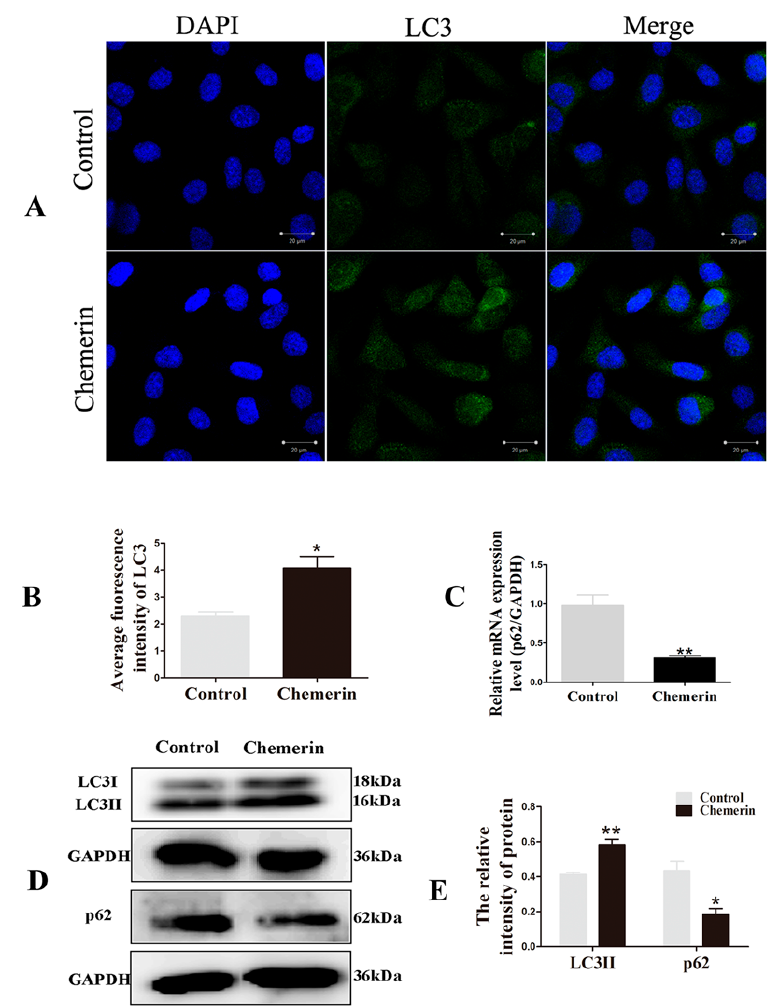
Figure 2. Chemerin promotes autophagy of BMECs. Cells were exposed to the culture medium with 0.1µg/mL Chemerin form 24 h. ( A ) LC3 protein distribution was detected by immunofluorescence staining. ( B ) The average fluorescence intensity of LC3 was determined in three randomly selected fields of view by Image J software. ( C ) Messenger RNA (mRNA) expression of sequestosome-1 ( SQSTM 1 , best known as p62 ) profiling. ( D ) Protein expression of LC3 and p62 was evaluated by Western blot. ( E ) The fluorescence intensity of protein was assayed by Image J software. All data were expressed as means ± SEM, with each treatment performed in triplicate. A single asterisk indicates a statistical di ff erence ( p < 0.05), and a double asterisk indicates a statistical di ff erence ( p < 0.01) when compared with